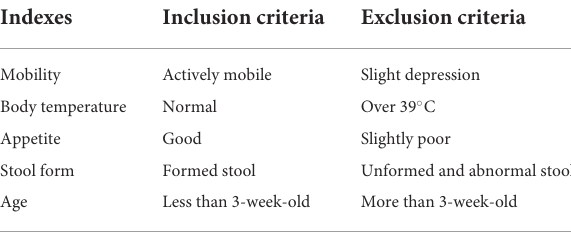
TABLE 1 Diagnostic criteria for DHD